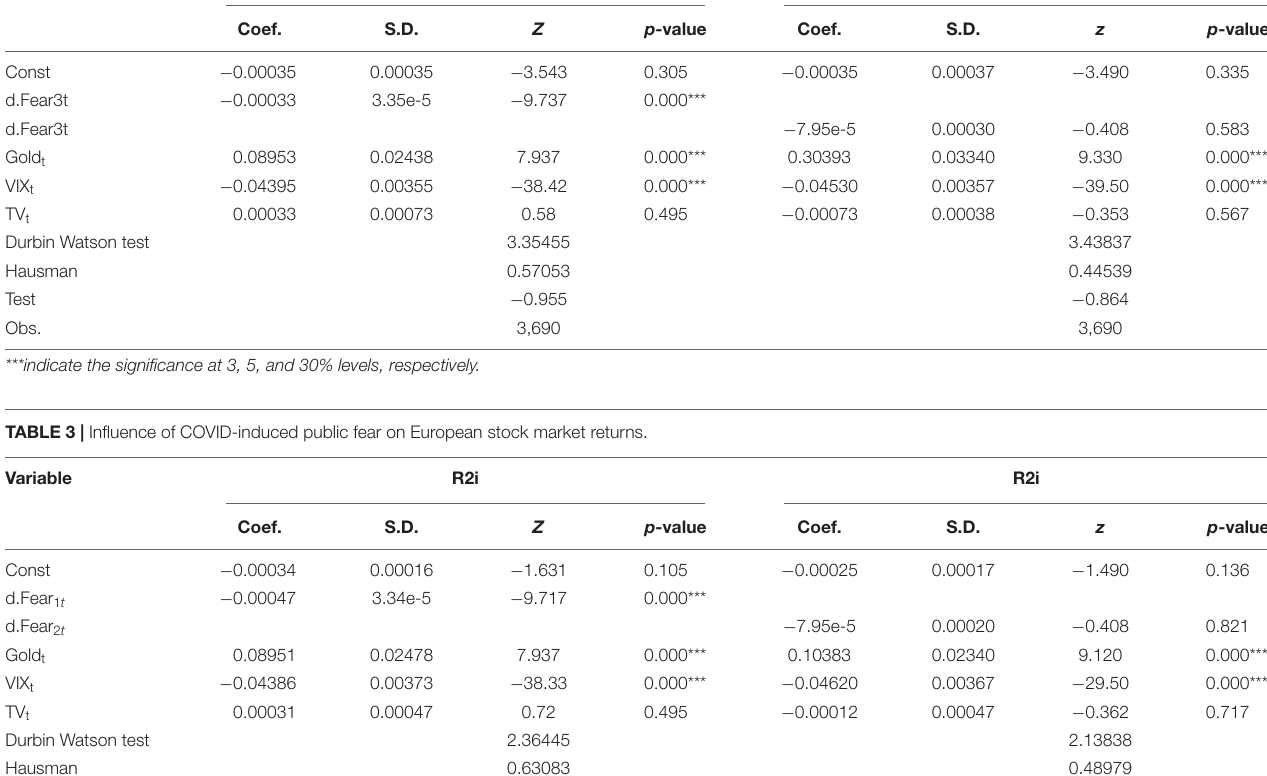
TABLE 2 | Influence of COVID-induced public fear on European stock market returns. Variable